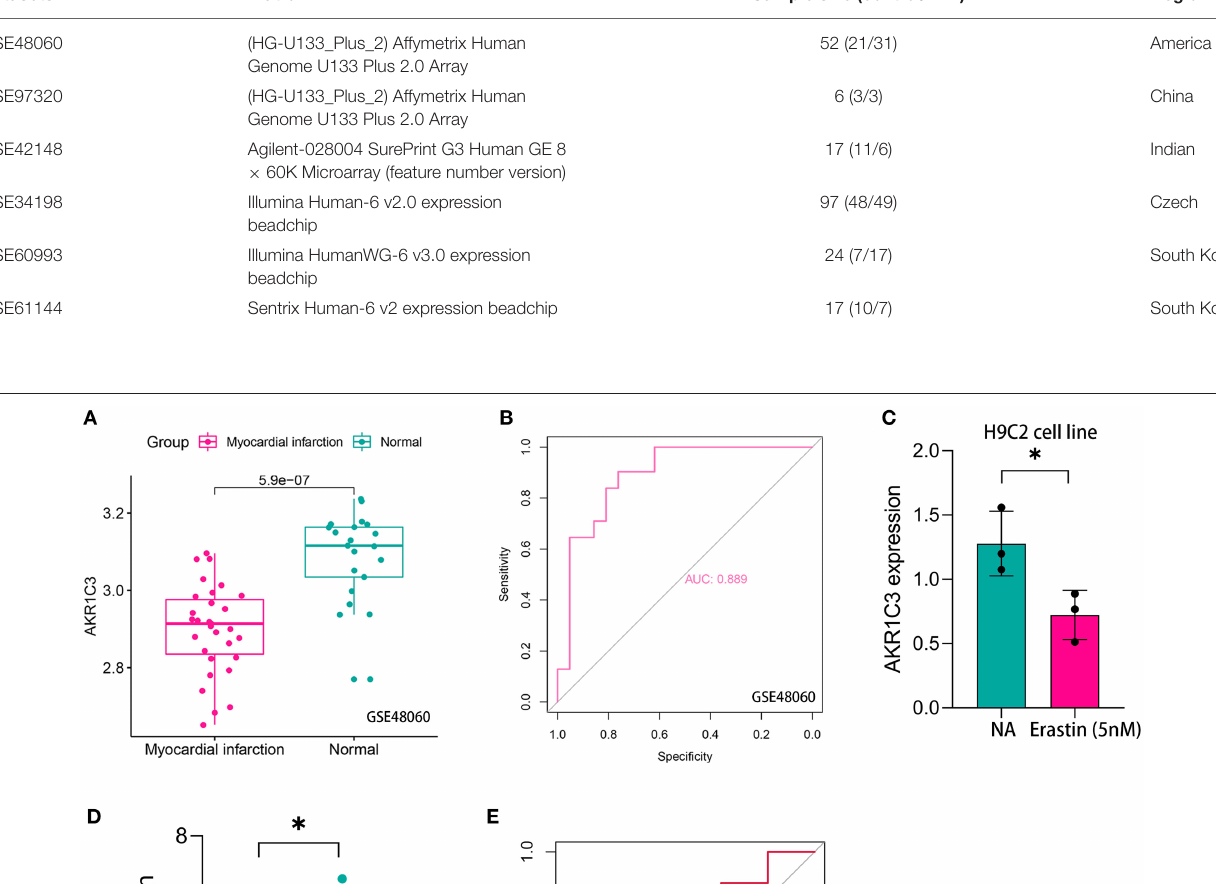
TABLE 1 | The microarray datasets enrolled in the study. Datasets